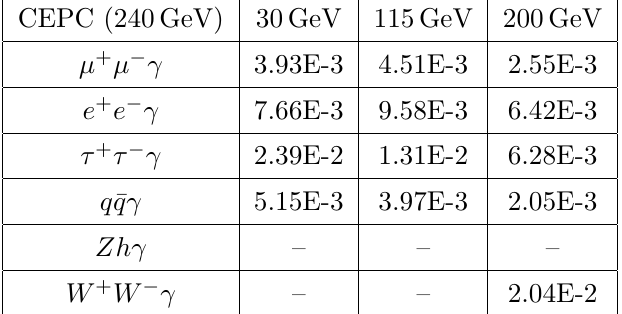
Table 3 . The values of (cid:15) corresponding to S= di(cid:11)erent channels at the 240 GeV CEPC with the integrated luminosity of 5 ab (cid:0) 1 . The notation of \aE-b" stands for a (cid:2) 10 (cid:0) b